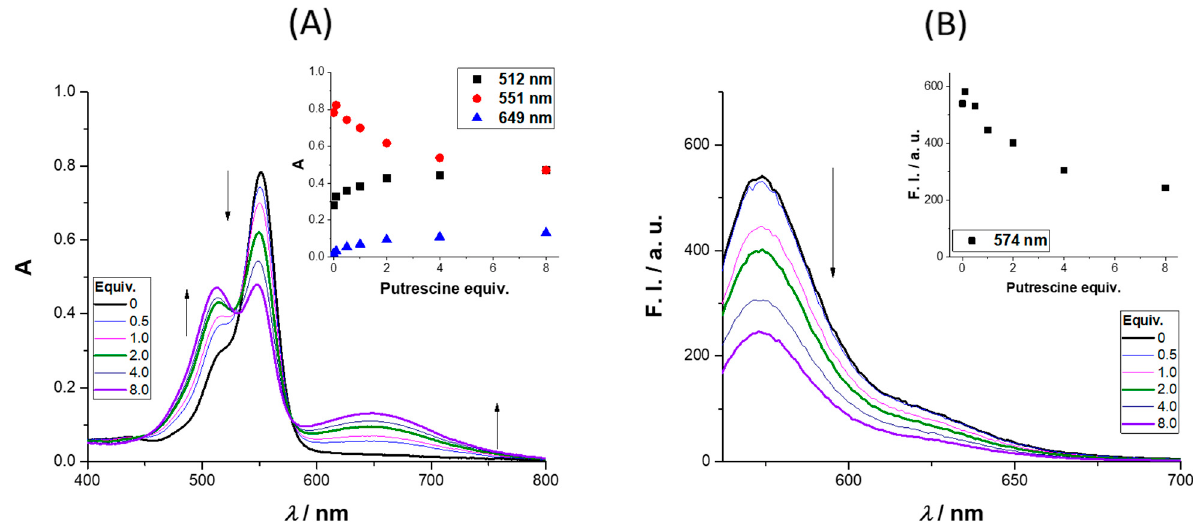
Figure 3. Absorption ( A ) and emission ( B ) spectra of 4 upon the addition (0–8 equiv.) of putrescine in CH 3 CN (the inset